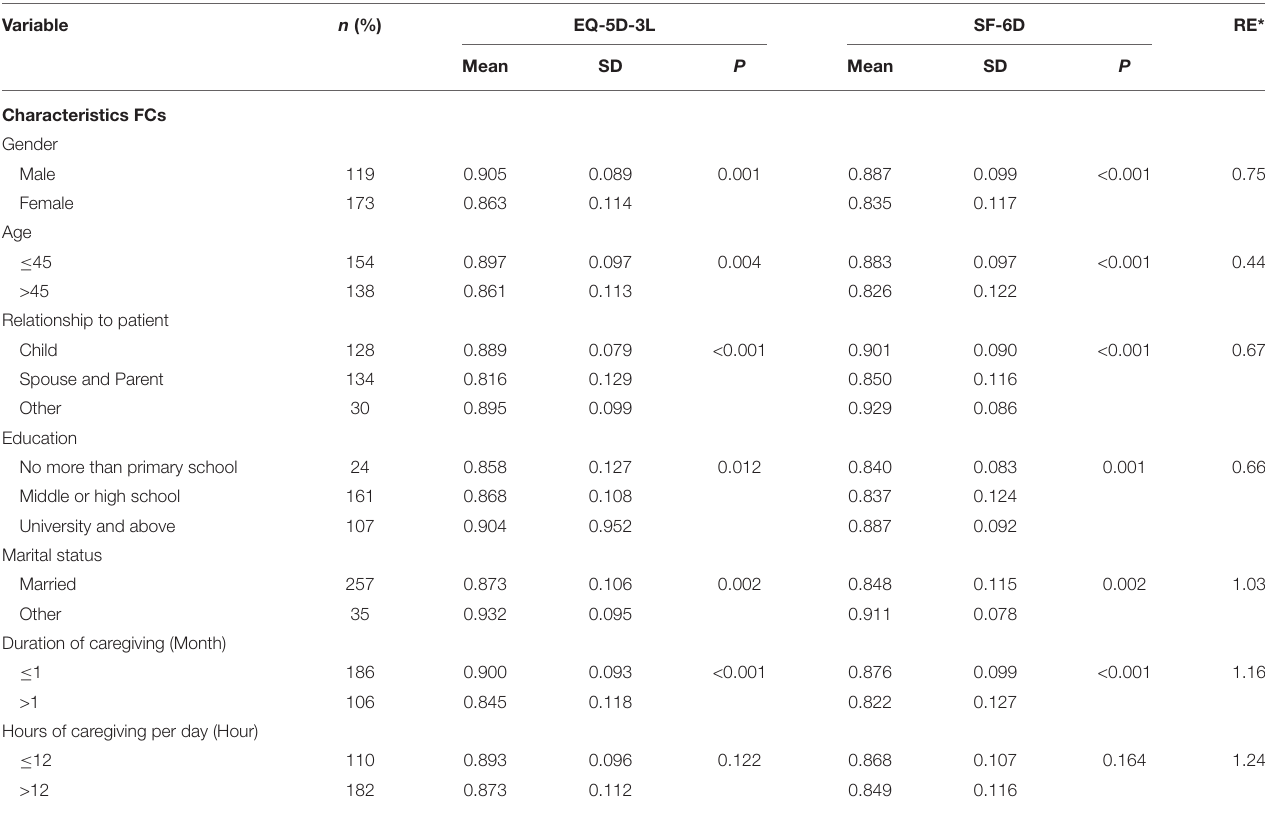
TABLE 4 | Known-groups validity and relative efficiency of the EQ-5D-3L and SF-6D.